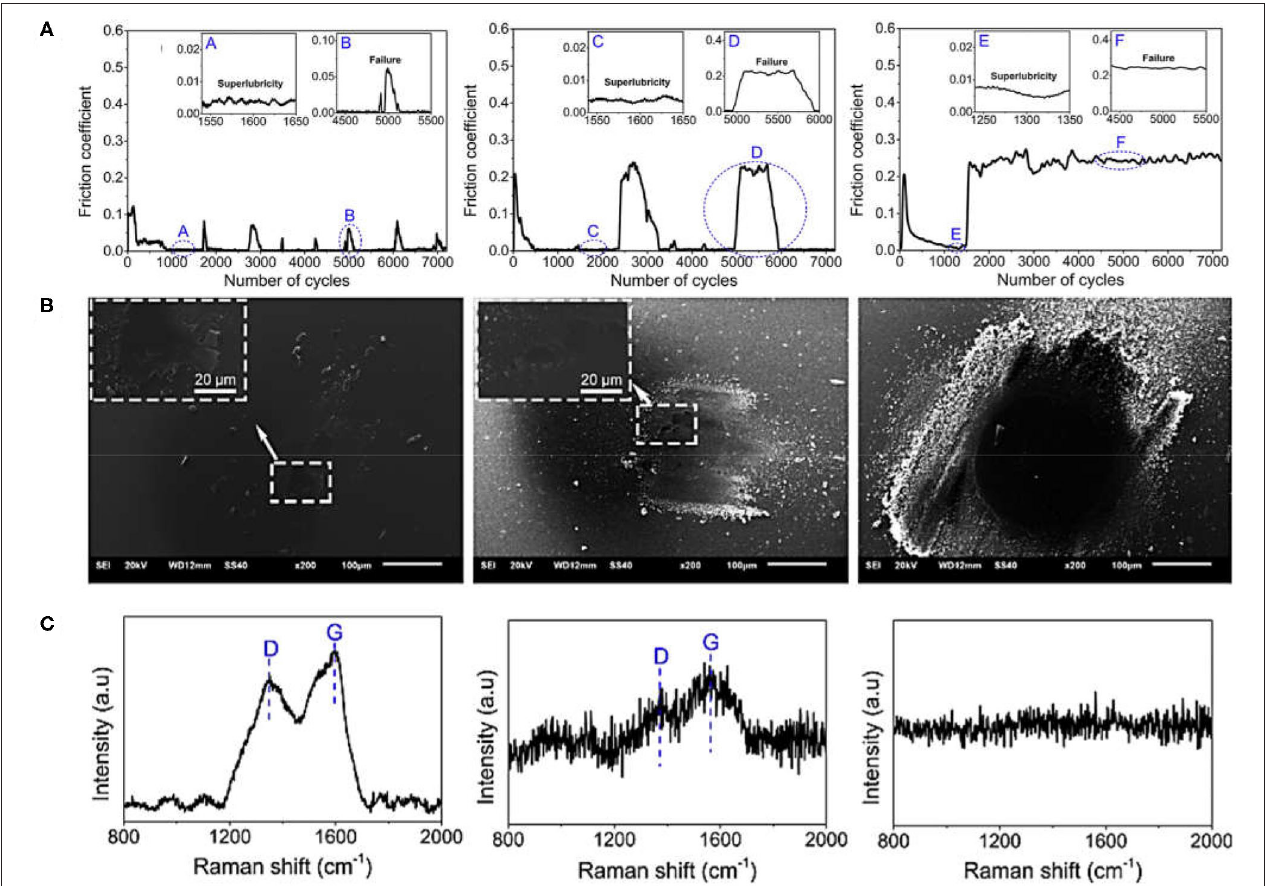
FIGURE 9 | Velocity dependence of transfer layers in vacuum. (A) Friction coefficient curves for a-C:H against Al 2 O 3 ball in vacuum at various sliding speeds. (B) SEM images and (C) Raman spectra of transfer layers generated in different sliding speeds. Adapted with permission from Liu et al. (2018) Copyright 2018, Elsevier